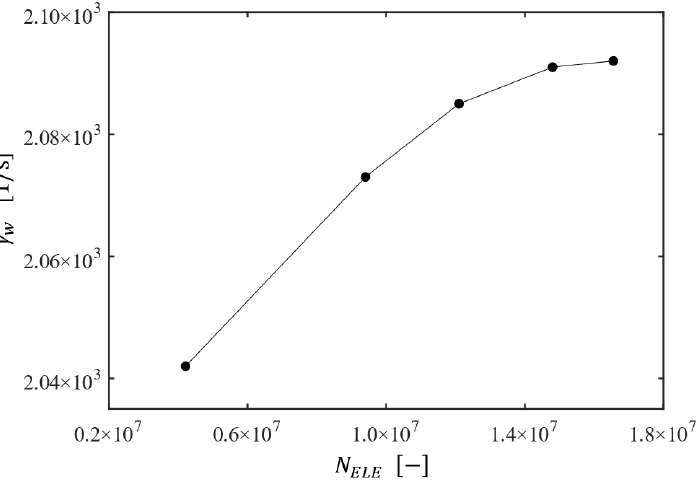
. γ w at the membrane wall as a function of the